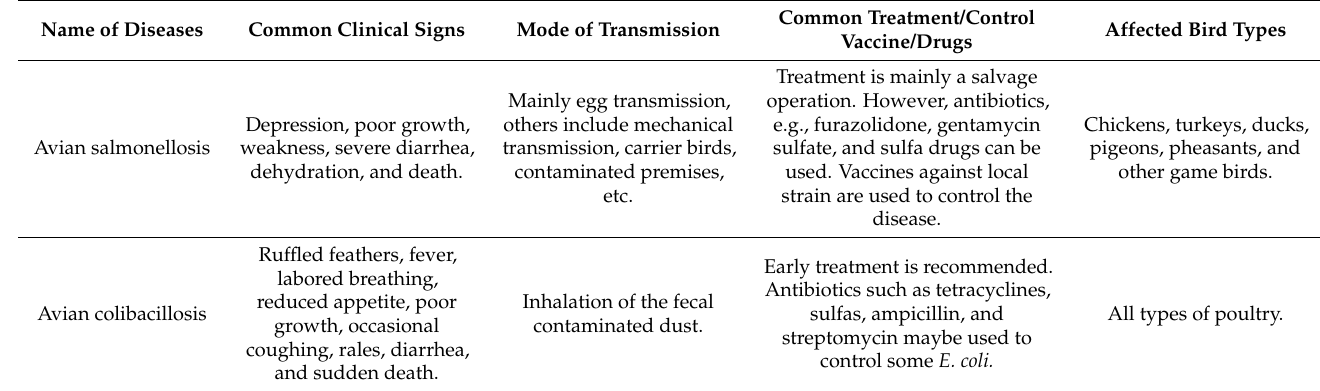
Table 1. List of bacterial diseases in poultry with their common clinical signs, mode of transmission, common treatments/control vaccines/drugs, and affected bird types